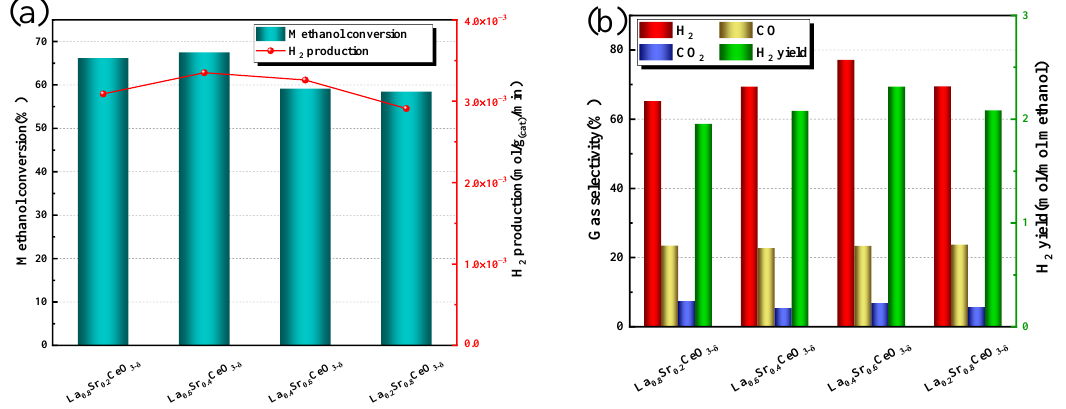
Figure 4. The MSR catalytic performance of the La 1-x Sr x CeO 3- δ (x = 0.2, 0.4, 0.6, 0.8): ( a ) methanol conversion (left Y) and hydrogen production of 1g catalyst (right Y); ( b ) gas selectivity (left Y) and hydrogen yield (right Y).